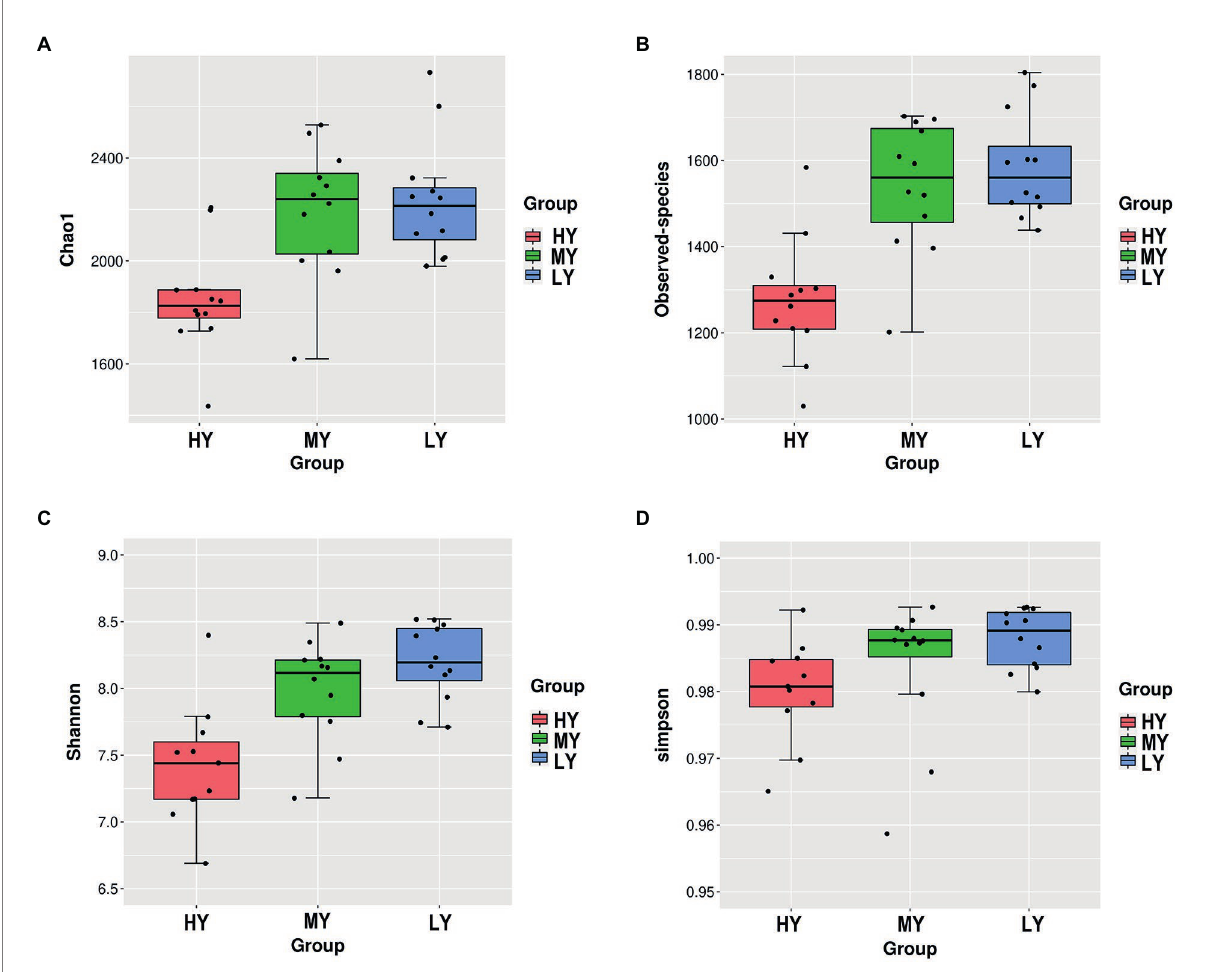
FIGURE 1 Differences in ruminal bacterial diversity and richness among groups. Bacterial richness was estimated by the observed-species and the Chao1 indices (A,B) . Bacterial diversity was estimated by Shannon and Simpson indices (C,D) . HY, high ME:N (0.42 MJ/g); MY, medium ME:N (0.36 MJ/g); LY, low ME:N (0.32